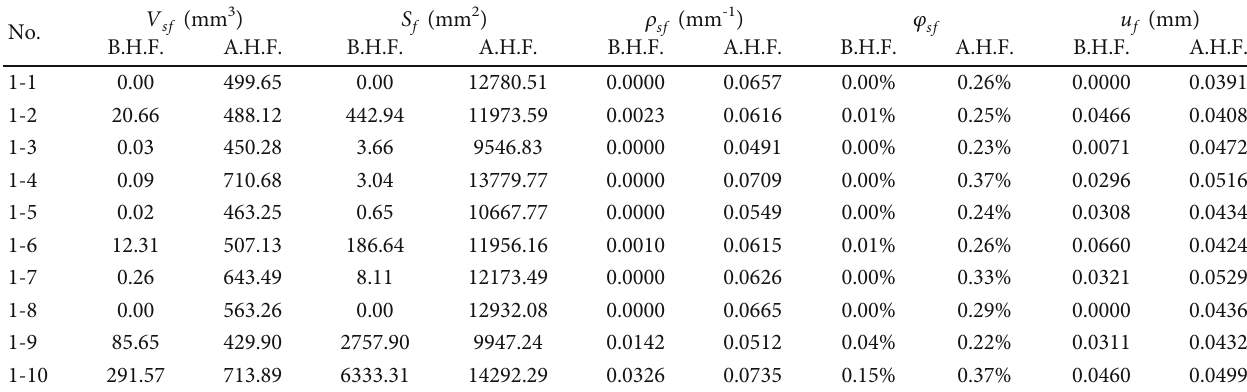
Table 3: Fracture parameters of samples before and after hydraulic